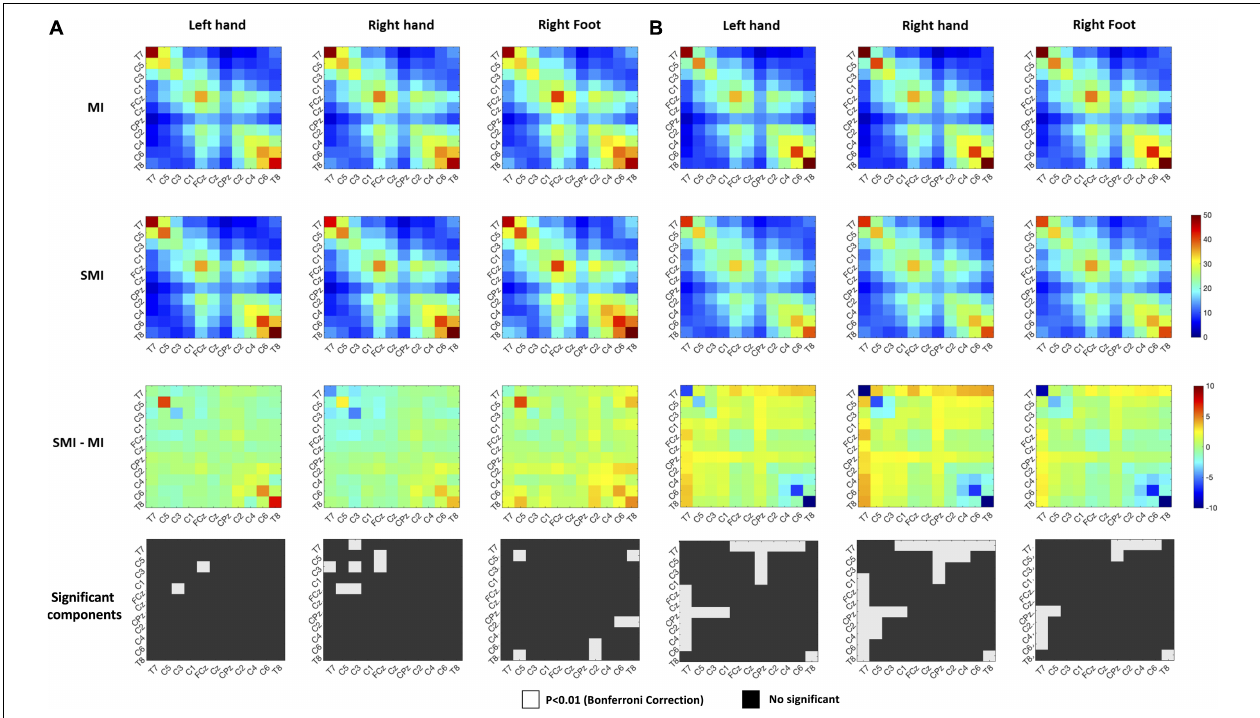
FIGURE 6 | Comparison of the right-hand covariance matrix heat maps of the motor imagery and somatosensory-motor imagery conditions to show relationships among 11 selected channels. (A) Good performer group. (B) Poor performer group. Color scales show the paired t-statistic. The significance test was two-tailed.